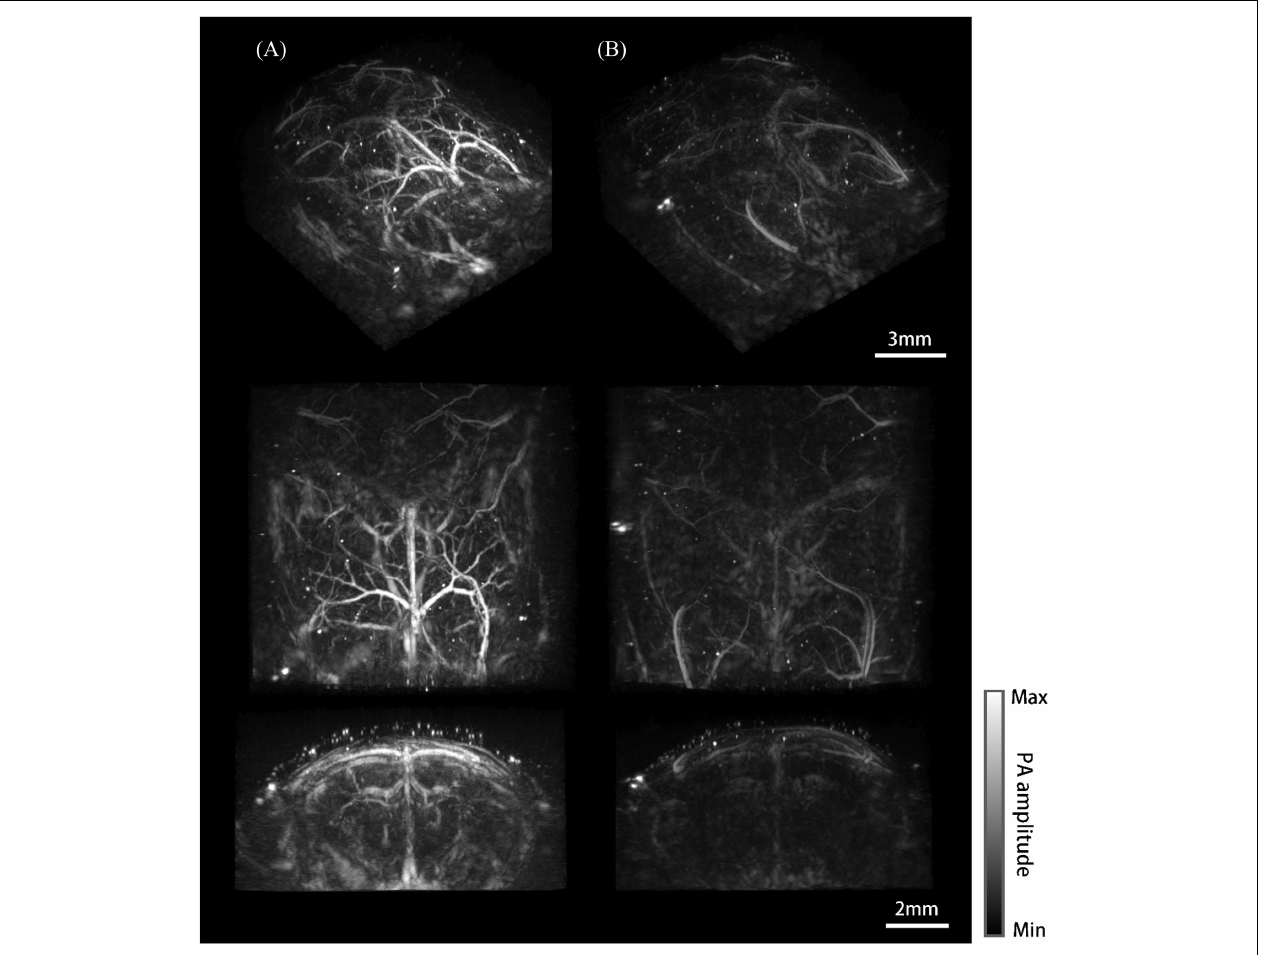
FIGURE 7 | Photoacoustic mesoscopy system and imaging results. (A) Whole-brain imaging results of the mouse model. From top to bottom are the maximum intensity projections (MIP) of the viewing perspective (a–c) shown in Figure 2C , respectively. (B) Imaging results of the normal